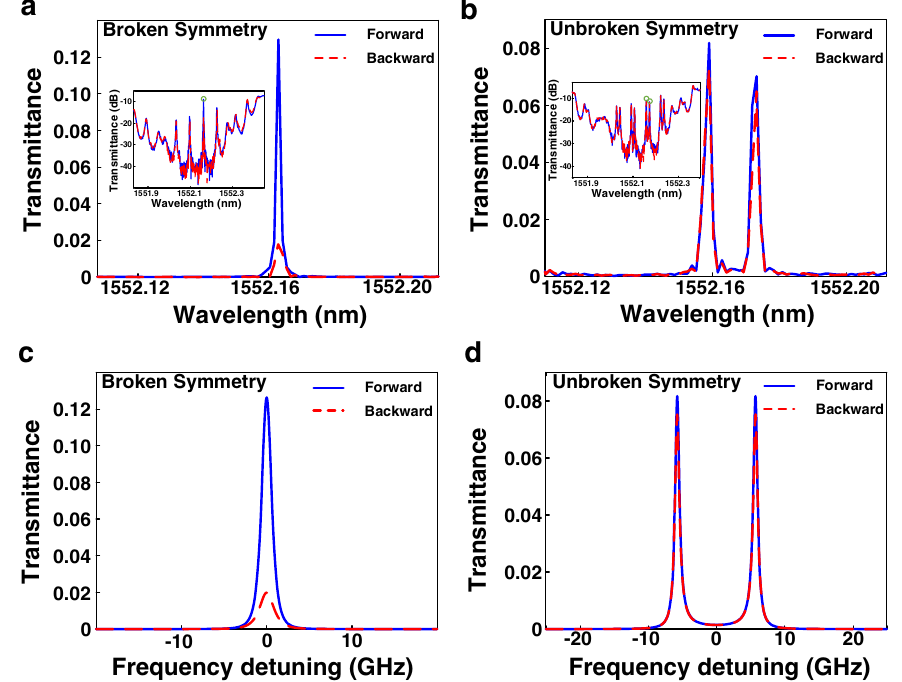
Fig. 4 Nonreciprocal light transmission. Experimental results of nonreciprocal light transmission of the device in a the broken PT-symmetric regime, and b in the unbroken PT-symmetric regime. Inset: the total transmission spectrum of the device in a logarithmic scale. c and d , Simulation results corresponding to those in a and b